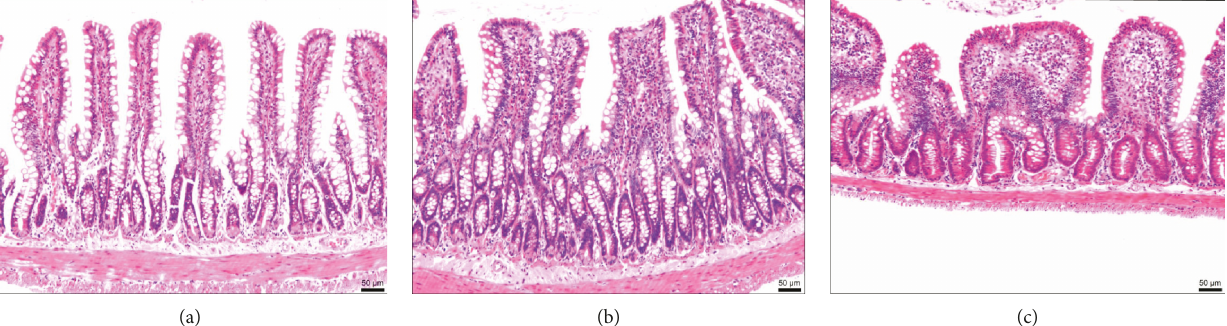
Figure 2: Light micrograph of ileal histopathology stained with haematoxylin and eosin (magni fi cation, × 100): (a) normal control group; (b) liver injury and treated with phosphatidylcholine group; (c) liver injury group.